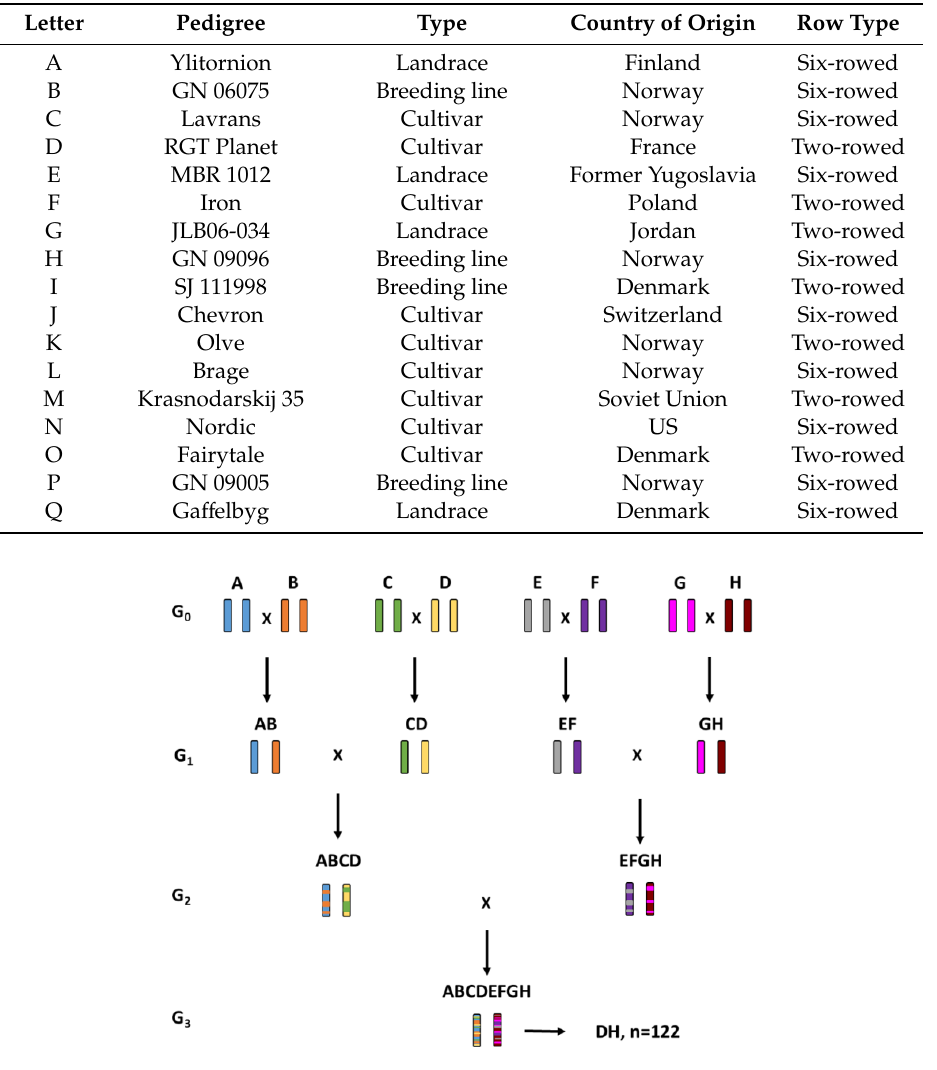
Figure 1. Crossing scheme of the eight-founder barley MAGIC populations, exemplary for MAGIC 1. Capital letters correspond to A: Ylitornion, B: GN 06075, C: Lavrans, D: RGT Planet, E: MBR 1012, F: Iron, G: JLB06-034. The name of each generation (G) can be found on the left side of the scheme indicated by a G followed by a lower-case number. DH means doubled haploid and n indicates the number of DH lines produced. Table 2. Crossing scheme for the four barley MAGIC